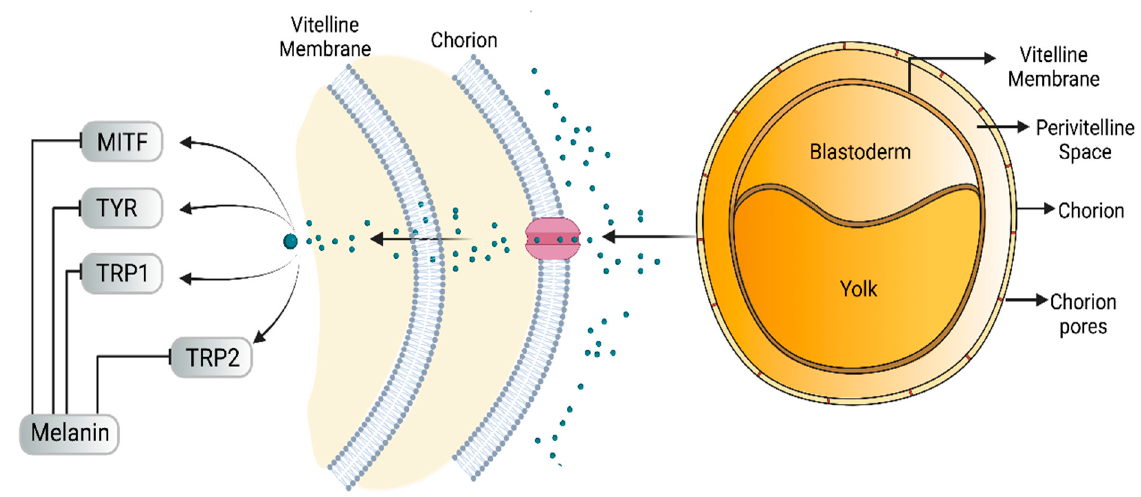
Figure 3. Schematic diagram showing the possible mechanism of action of depigmenting agents on zebrafish embryo. The embryonic chorion is composed of a nanoporous outer membrane 500–700 µ M in diameter. The chorion is composed of a three-layer structure (extraembryonic mesoderm) with four main polypeptides. Small or hydrophobic molecules can diffuse across the lipid bilayer (adapted from Bonsignorio et al. [70]; Jon et al. [71]).